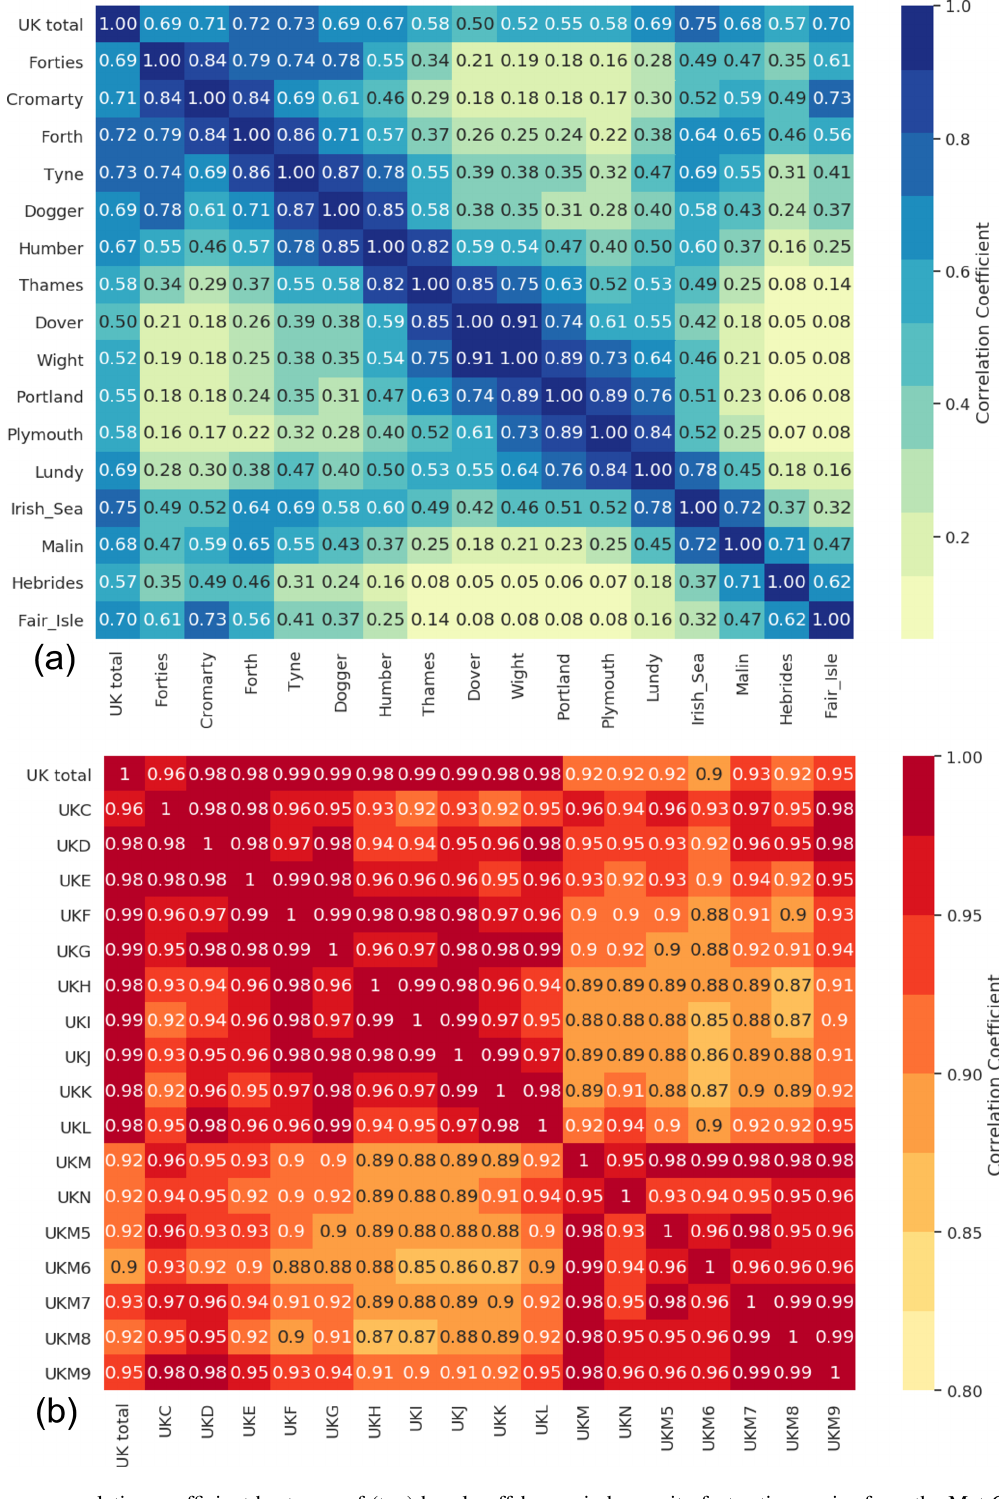
Earth Syst. Sci. Data, 14, 2749–2766,